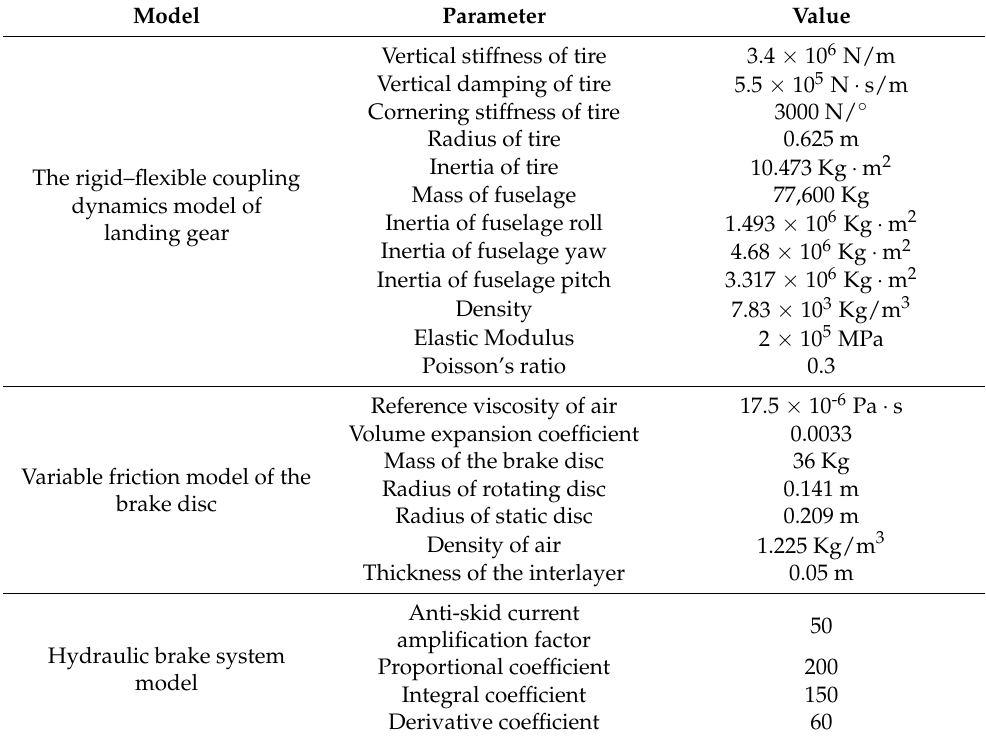
Table 1. Simulation